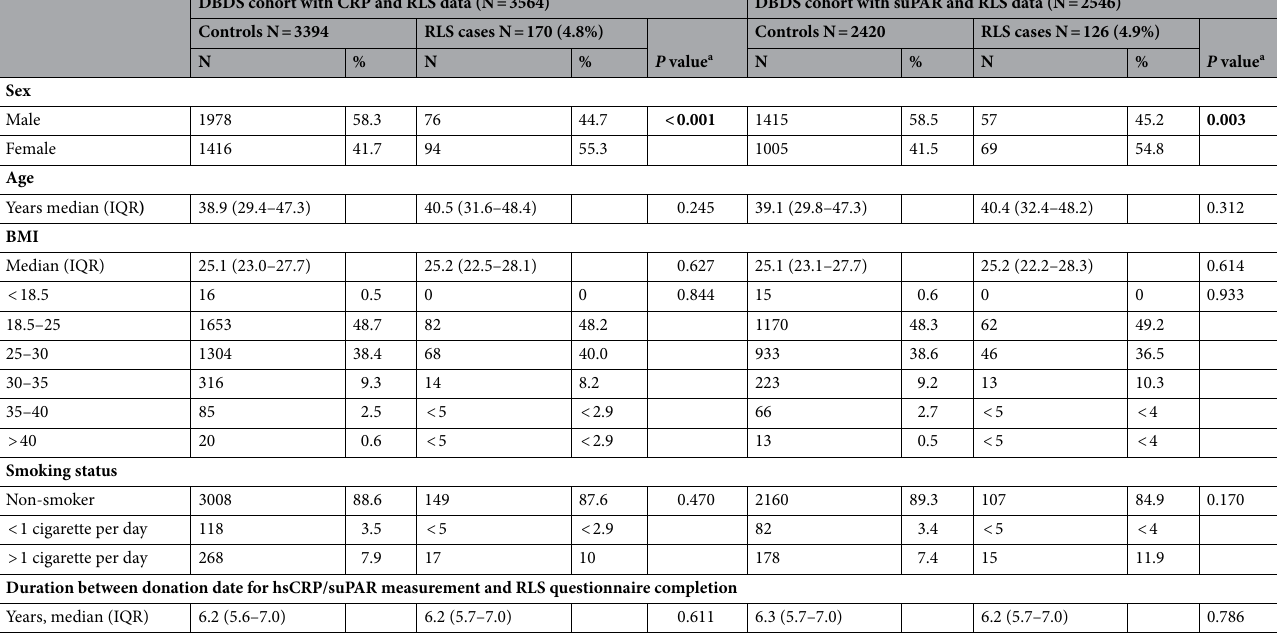
Table 1. Demographic descriptive statistics of RLS cases and controls in the DBDS cohort with available CRP data (N = 3564) and the DBDS cohort with available suPAR data (N = 2546). DBDS danish blood donor study cohort, IQR interquartile range. a For comparison of the two groups, chi-square test was used for categorical variables and Kruskal–Wallis rank test was used for continuous variables. Significant values are in [bold].